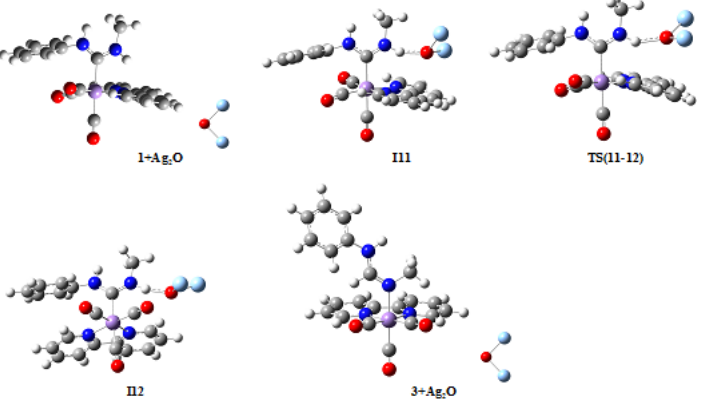
Figure 8. Molecular structures of compounds in the M3 mechanism. Larger figures are given in the Supplementary Material (Figure S3). Color codes: Mn (magenta), C (grey), O (red), N (dark blue), H (white), and Ag (light blue). Table 5. Selected bond lengths (Å) of theoretically optimized structures (B3P86/6-31+G(d),